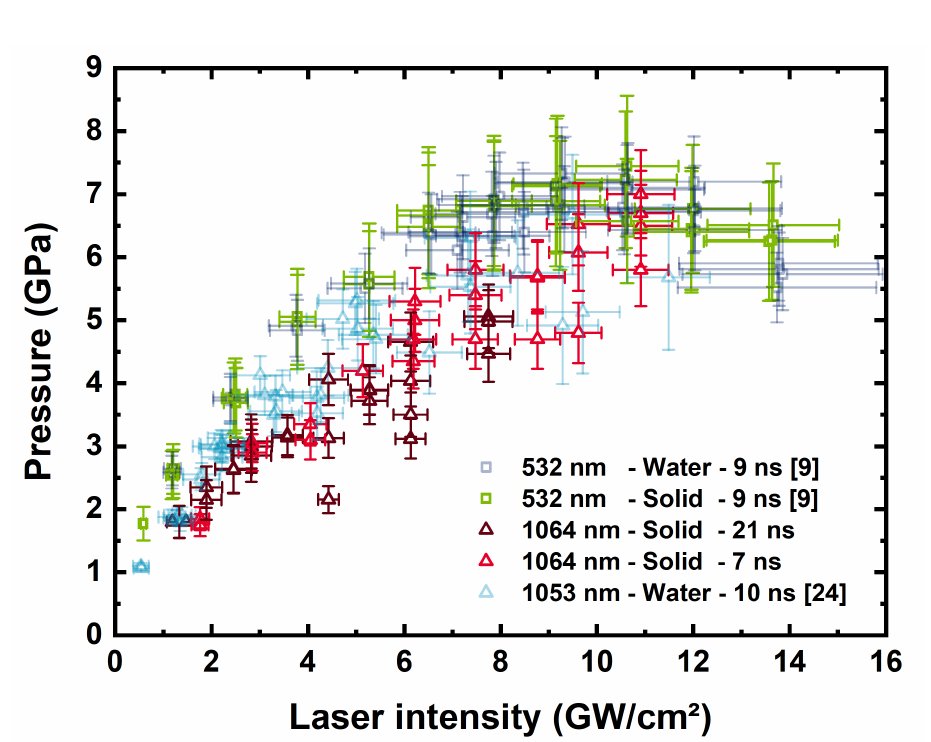
Figure 3. Pressure measurements obtained from VISAR measurements with the polymer confinement at 1064 nm for a 7 and 21 ns laser pulse. Results are compared with pressures obtained in [9] at 532 nm with a pulse duration of 9 ns and with results at 1053 nm with a pulse duration of 10 ns from